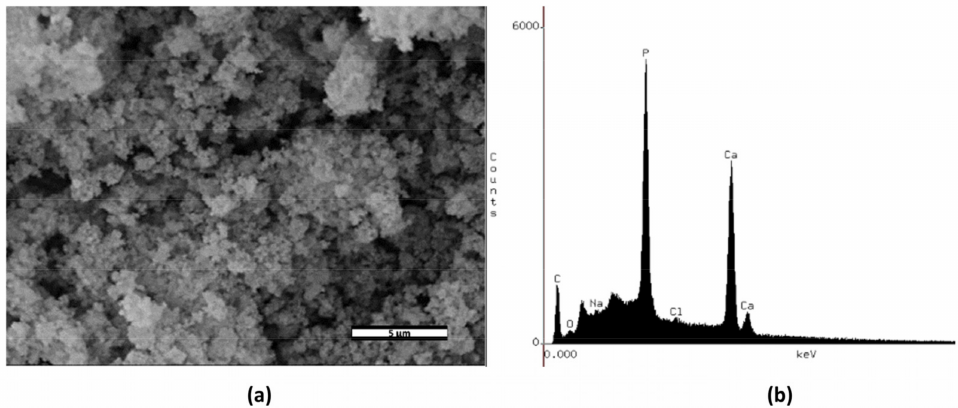
Figure 1. Morphological and chemical characterization of the synthesized calcium-polyphosphate particles: ( a ) scanning electron microscopy (SEM) images ( × 5000); ( b ) energy-dispersive X-ray analysis